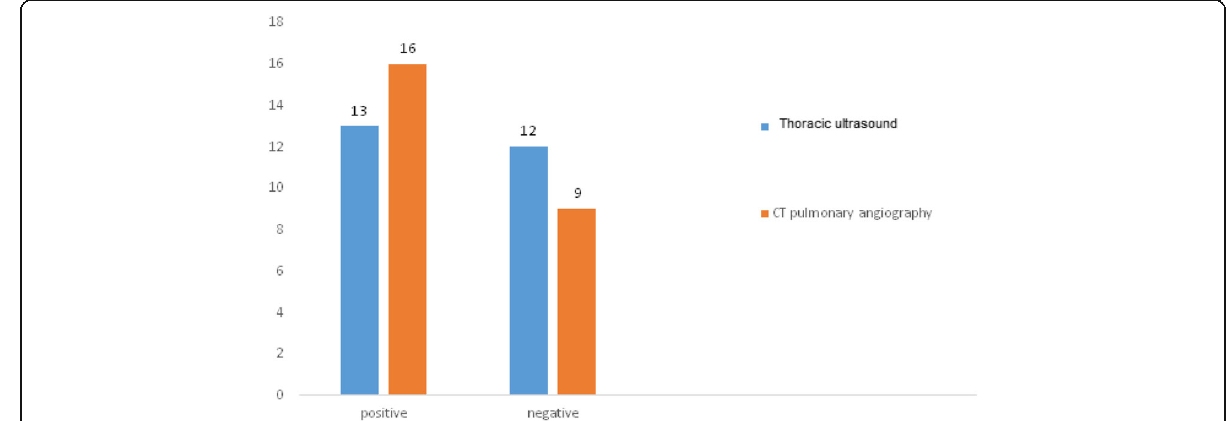
Fig. 1 A chart demonstrating the results of the thoracic ultrasound correlated to the CT pulmonary